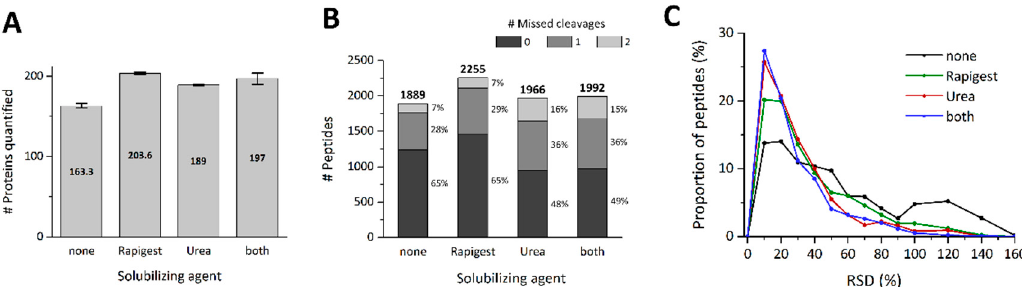
Figure 4. Impact of solubilizing agents during on-particle digestion of the SiO 2 NM corona on the total numbers of ( A ) proteins and ( B ) peptides identified in three experimental replicates, and ( C ) on the reproducibility in peptide quantification within triplicate experiments.